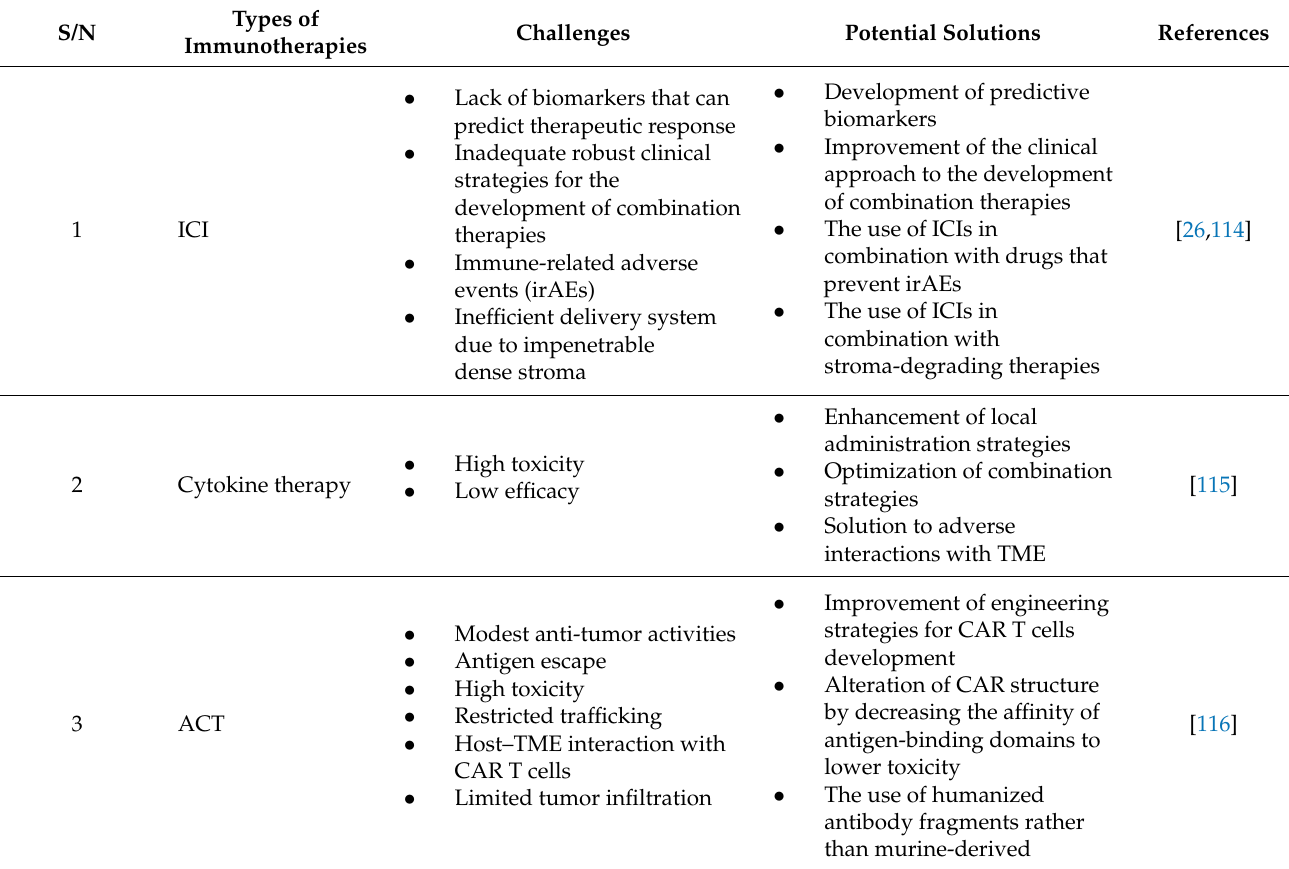
Table 3. Challenges and potential solutions for each type of